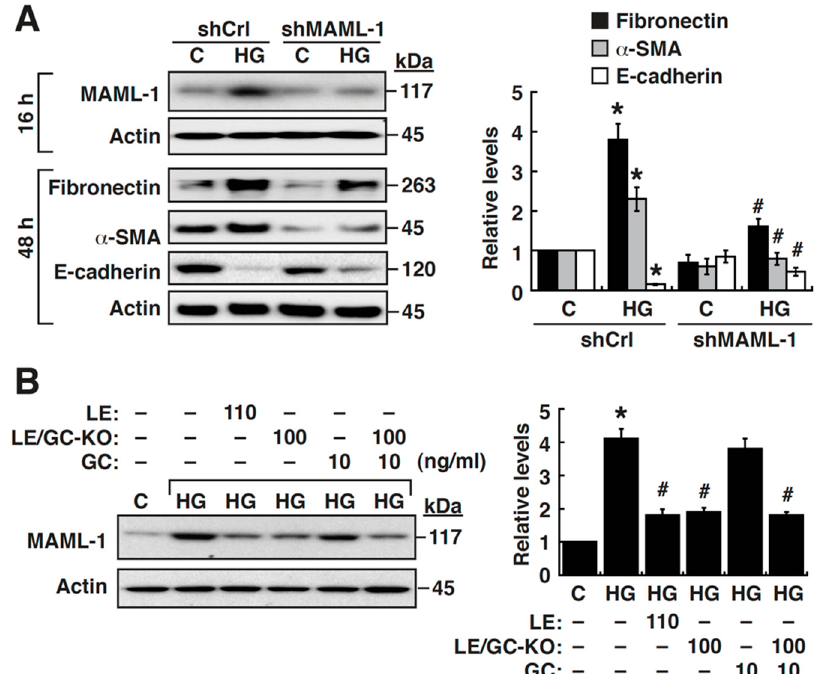
Figure 4. Upregulated expression of MAML-1 is critical for HG-mediated EMT activation in NRK-52E cells, which can be attenuated by LE or LE / GC-KO. ( A ) Suppression of HG-induced EMT in NRK-52E cells by knockdown of MAML-1. Cells were harvested at the indicated time points (16 h or 48 h) after shRNA transfection, and Western blot analysis was performed. * p < 0.05 versus the normal control, # p < 0.05 versus the control shRNA (short hairpin RNA) group with HG incubation ( n = 3). ( B ) Changes in MAML-1 expression in HG-cultured NRK-52E cells treated with LE (110 ng / mL), LE / GC-KO (100 ng / mL), GC (10 ng / mL), or the combination of LE / GC-KO (100 ng / mL) and GC (10 ng / mL). At 16 h after treatment, cells were harvested for Western blotting. * p < 0.05 versus the normal control, # p < 0.05 versus untreated HG-cultured cells ( n = 3).